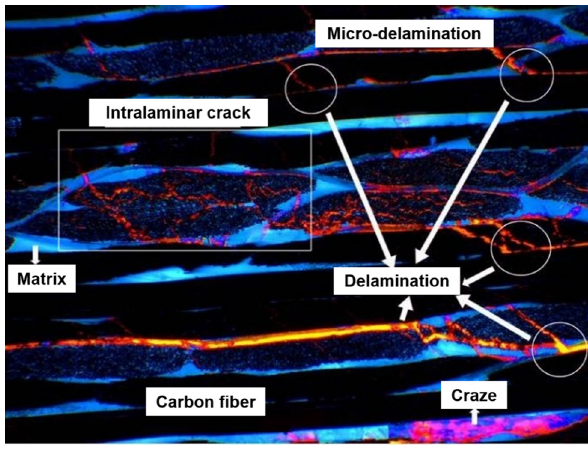
Figure 8: Optical micrograph of the cross section with matrix damage and